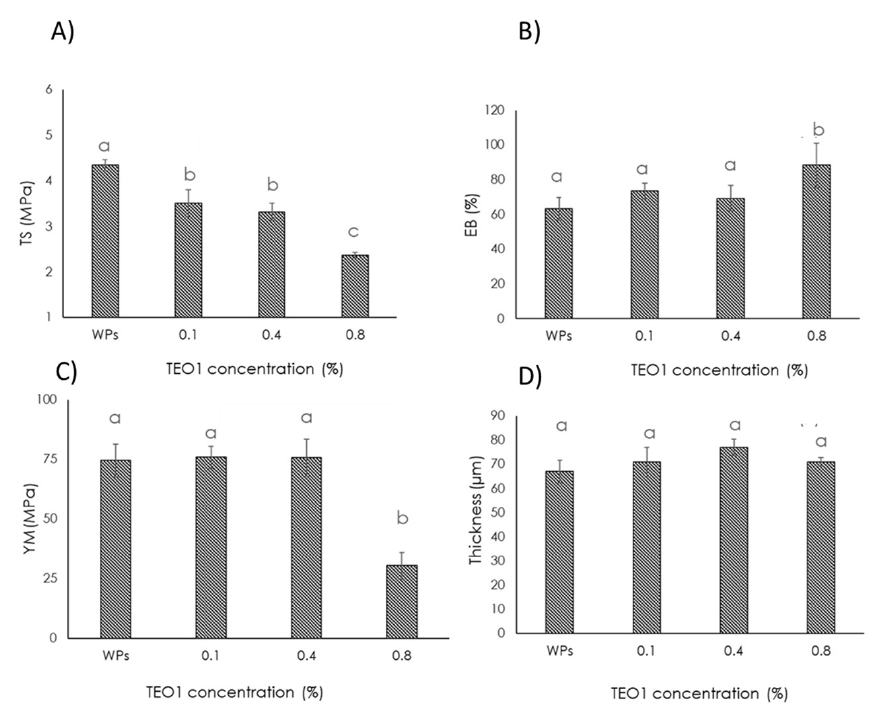
Figure 5. Thickness and mechanical properties of WP (500 mg)-based films prepared either in the absence or presence of different concentrations of Thymbra essential oil (TEO1) (%, v/v). Values are the mean ± SD and the different letters indicate significant differences in the values (Tukey-Kramer test, p < 0.05). ( A ) tensile strength (TS), ( B ) elongation at break (EB), ( C ) Young’s modulus (YM), ( D ) Thickness.